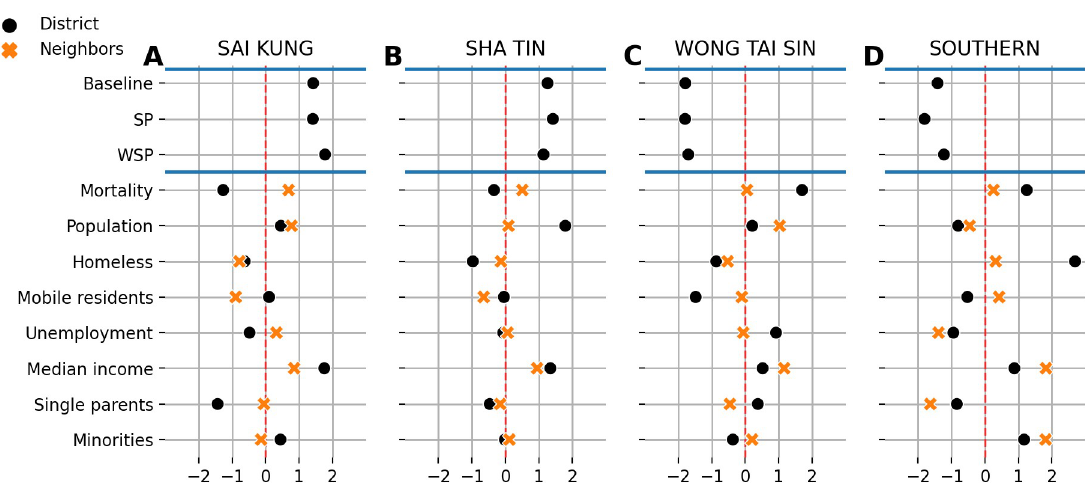
Fig 5. Impact of sociospatial factors on mortality risks. The first three rows show the mean signed deviation for four districts that are poorly fit by our models. ( A, B ) We show districts with systematic overestimation of mortality rates, while ( C, D ) show districts where mortality rates are systematically underestimated. For each district, we show the normalized value of some features of interest (black markers) along with the average value of the same features in the neighboring districts (orange markers). The red dashed line shows the average value for each of these normalized features centered at zero. We can see evidence of sociospatial factors of longevity in all four districts. Particularly, we note a spillover of wealth measured by median income. Districts in ( A ) and ( B ) maintain lower mortality rates while surrounded by districts with average mortality rates. Districts in ( C ) and ( D ) have a socioeconomic pull, driving the entire neighborhood to have higher mortality